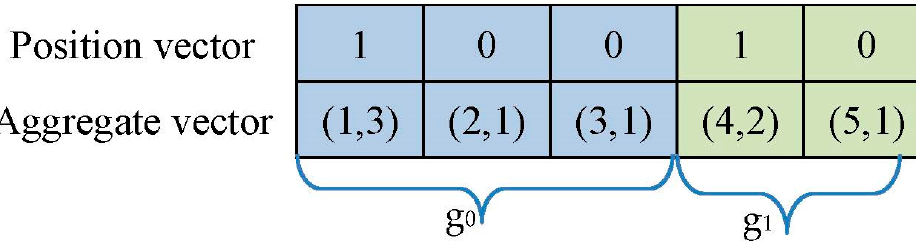
Figure 6. The final position vector.